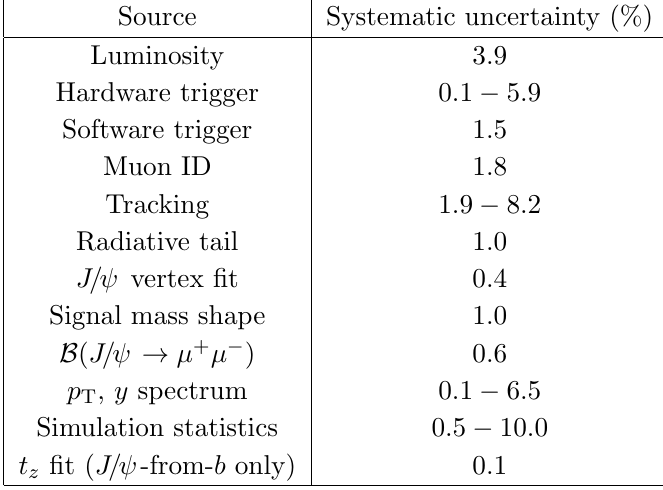
Table 1 . Relative systematic uncertainties (in %) on the J= cross-section measurements. The uncertainty from the t z (cid:12)t only a(cid:11)ects J= -from- b mesons. Most of the uncertainties are fully statistics, which are considered uncorrelated.